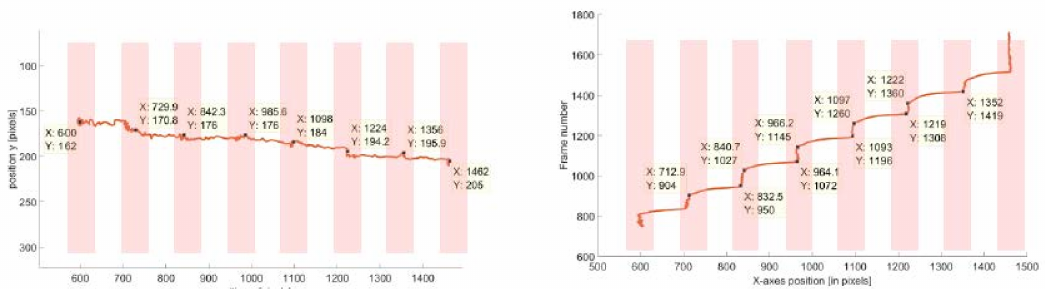
Figure 6. Method for representation of an MP’s motion over a sequence of frames for a single field of view (FOV). The figure on the left shows the trajectory of an individual MP with respect to x and y coordinates in (pixels). The particle is manipulated from the most left MC to the right side. Tracking starts when the MP position is at ( X : 600, Y : 162) and ends on ( X : 1462, Y : 205). There are visible changes in trajectory which indicate that the MP was captured at the MC (estimated x and y positions of capture are given in data boxes). Another representation of the MPs motion is shown in the figure on the right. Here, only the motion in x -direction (i.e., the direction of the magnetic field gradient) over the sequence of succeeding frames is